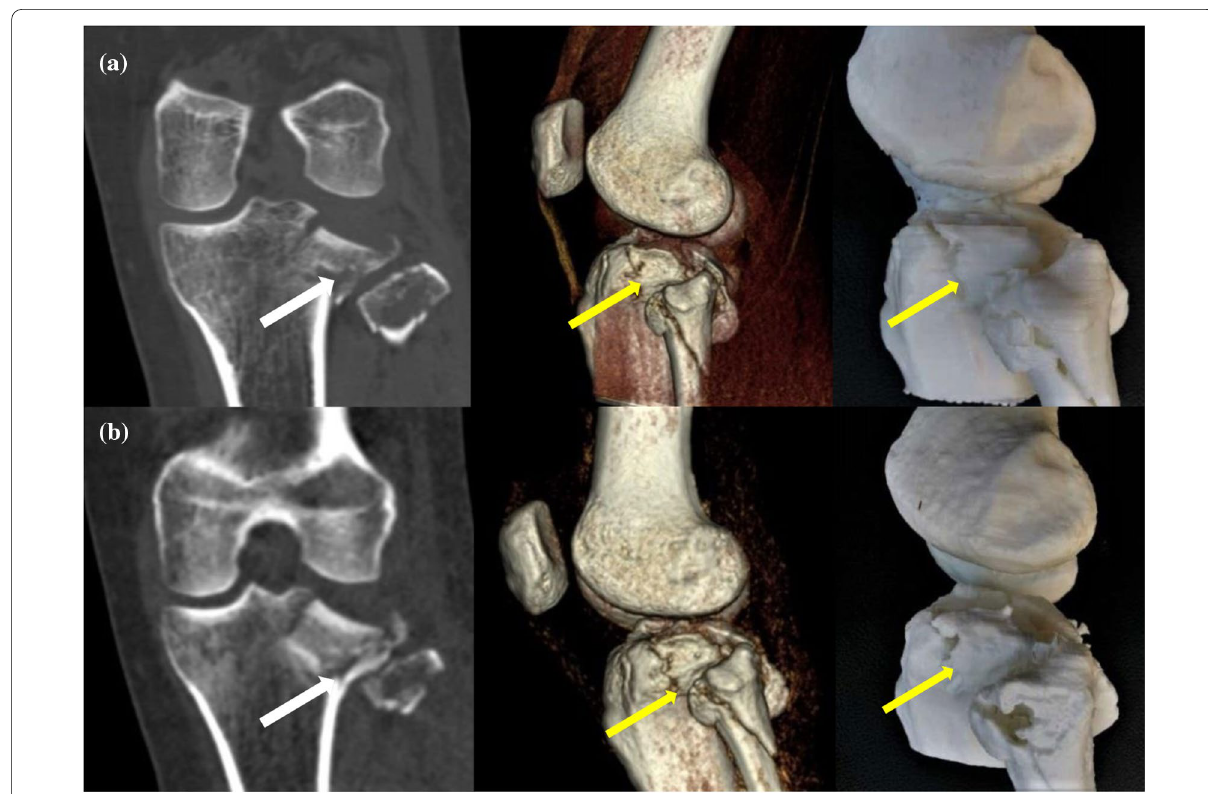
Fig. 2 Representative case study 2. A 36-year-old woman with comminuted fracture of tibial plateau and fibula underwent two scans (at the first visit and 8 days later). The standard-dose ( a ) and ultra-low-dose ( b ) protocols were used to generate three-dimensional printing models from 3D CT data. The direction of the image quality (white arrows) and locations of the fragments (yellow arrows) are identifiable with both scans,